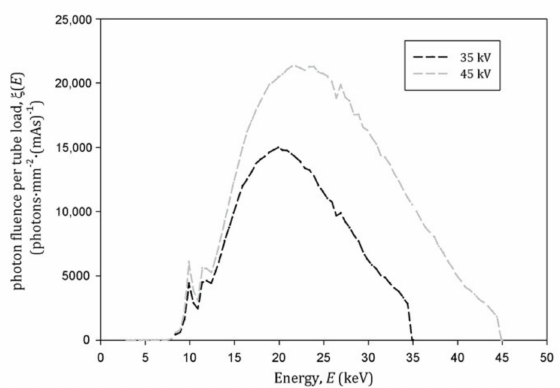
Figure 4. X-ray fluence spectra calculated with the polynomial interpolation coefficients reported by Moya et al. for tungsten anode. Both spectra were analytically attenuated by an added filtration of 0.5 mm Al. The L -lines at 8.4 and 9.4 keV appear as a single line because of the limited energy